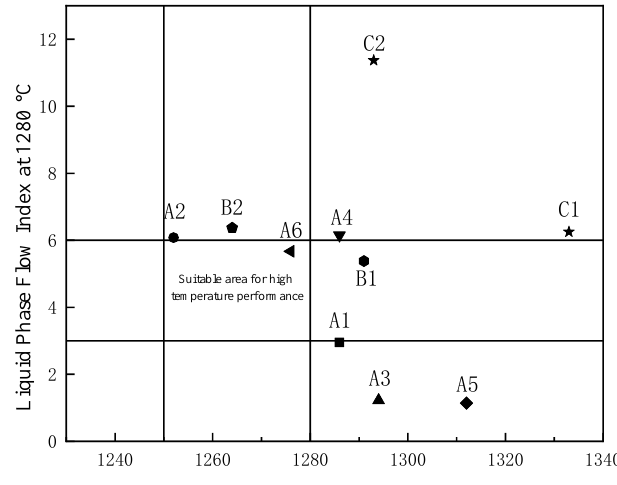
Figure 10. Schematic diagram of optimal collocation of iron ore powder.